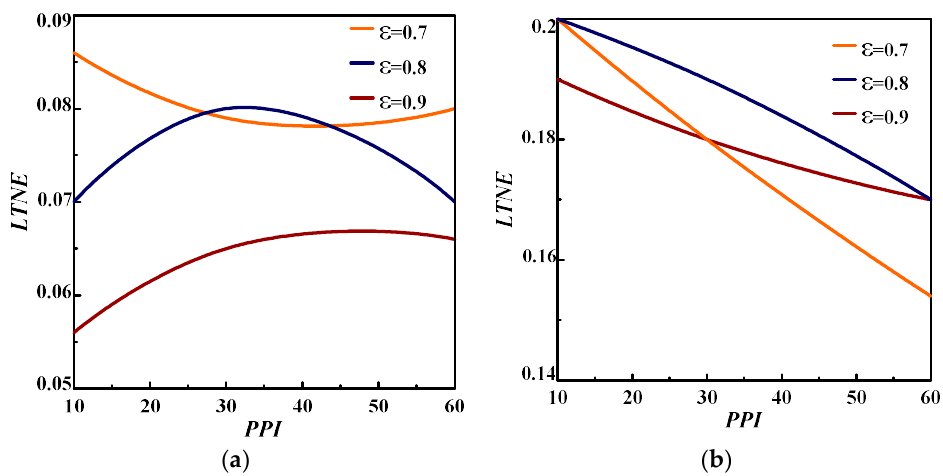
Figure 6. Pore density effect on LTNE criteria for Re=200 during: ( a ) charging case; ( b ) discharging case.